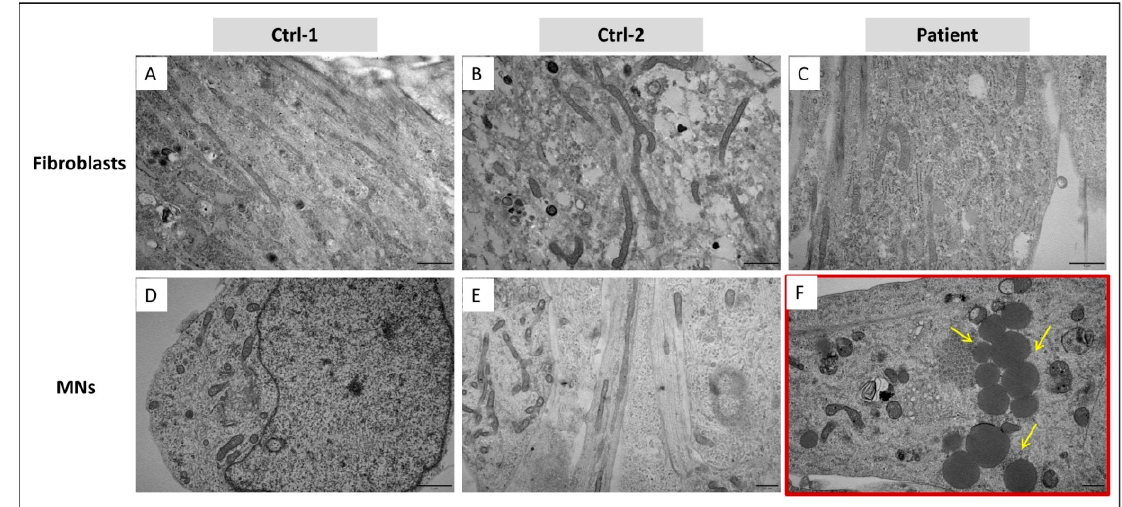
Figure 7. DAPI staining on MNs from patient vs. Ctrl-1 ( A ), and Ctrl-2 ( B ), at day 7 after the beginning of the differentiation process. *** p < 0.001 vs. Ctrl-1; ### p < 0.001 vs. Ctrl-2. 3.5. In MNs, GDAP1 Mutation Is Associated with Cytosolic Lipid Droplets and Perturbed Mitochondrial Morphology